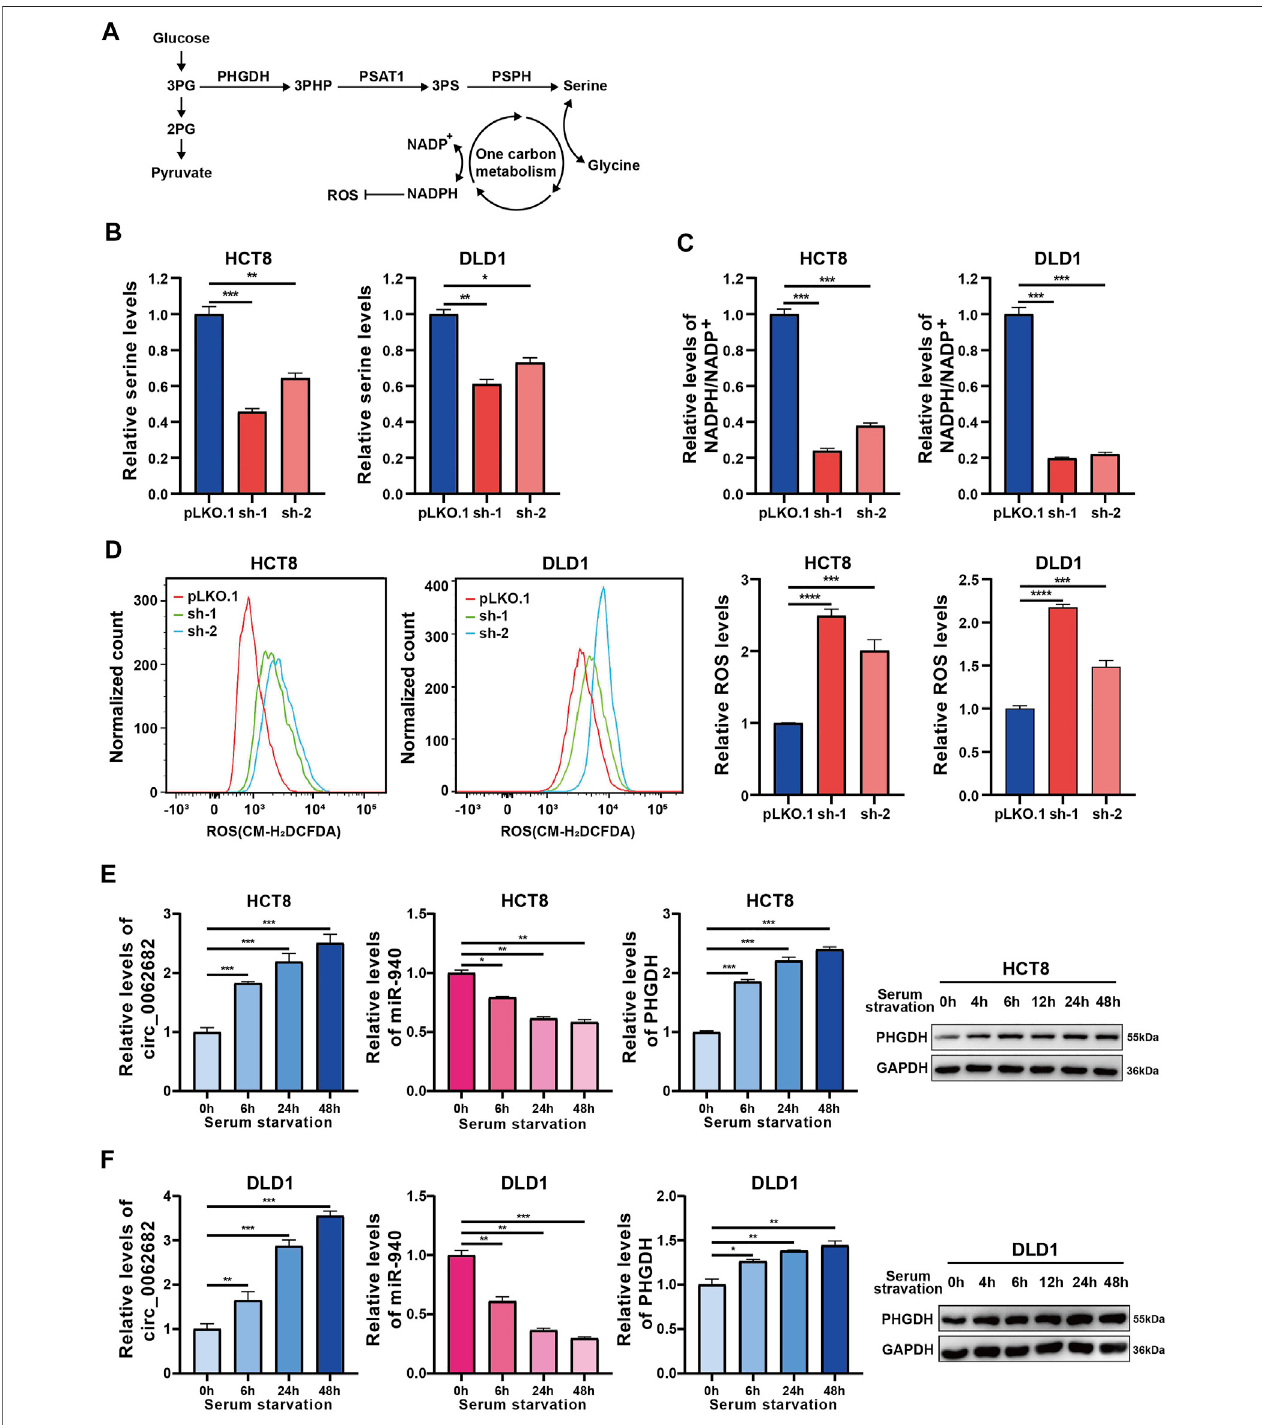
FIGURE 5 | Circ_0062682 promotes serine metabolism through the miR-940/PHGDH axis. (A) De novo serine biosynthesis diverges from glycolysis. (B) Intracellular serine levels were measured by LC-MS in circ_0062682-silenced CRC cells. (C) Intracellular NADPH levels were measured in circ_0062682-silenced CRC cells. (D) ROSlevelsweremeasuredincirc_0062682-silencedCRCcells. (E,F) Theexpressionofcirc_0062682,miR-940,andPHGDHinCRCcellswasmeasuredafter serum starvation for the indicated times by qRT-PCR or western blotting. * p < 0.05; ** p < 0.001; *** p < 0.001.